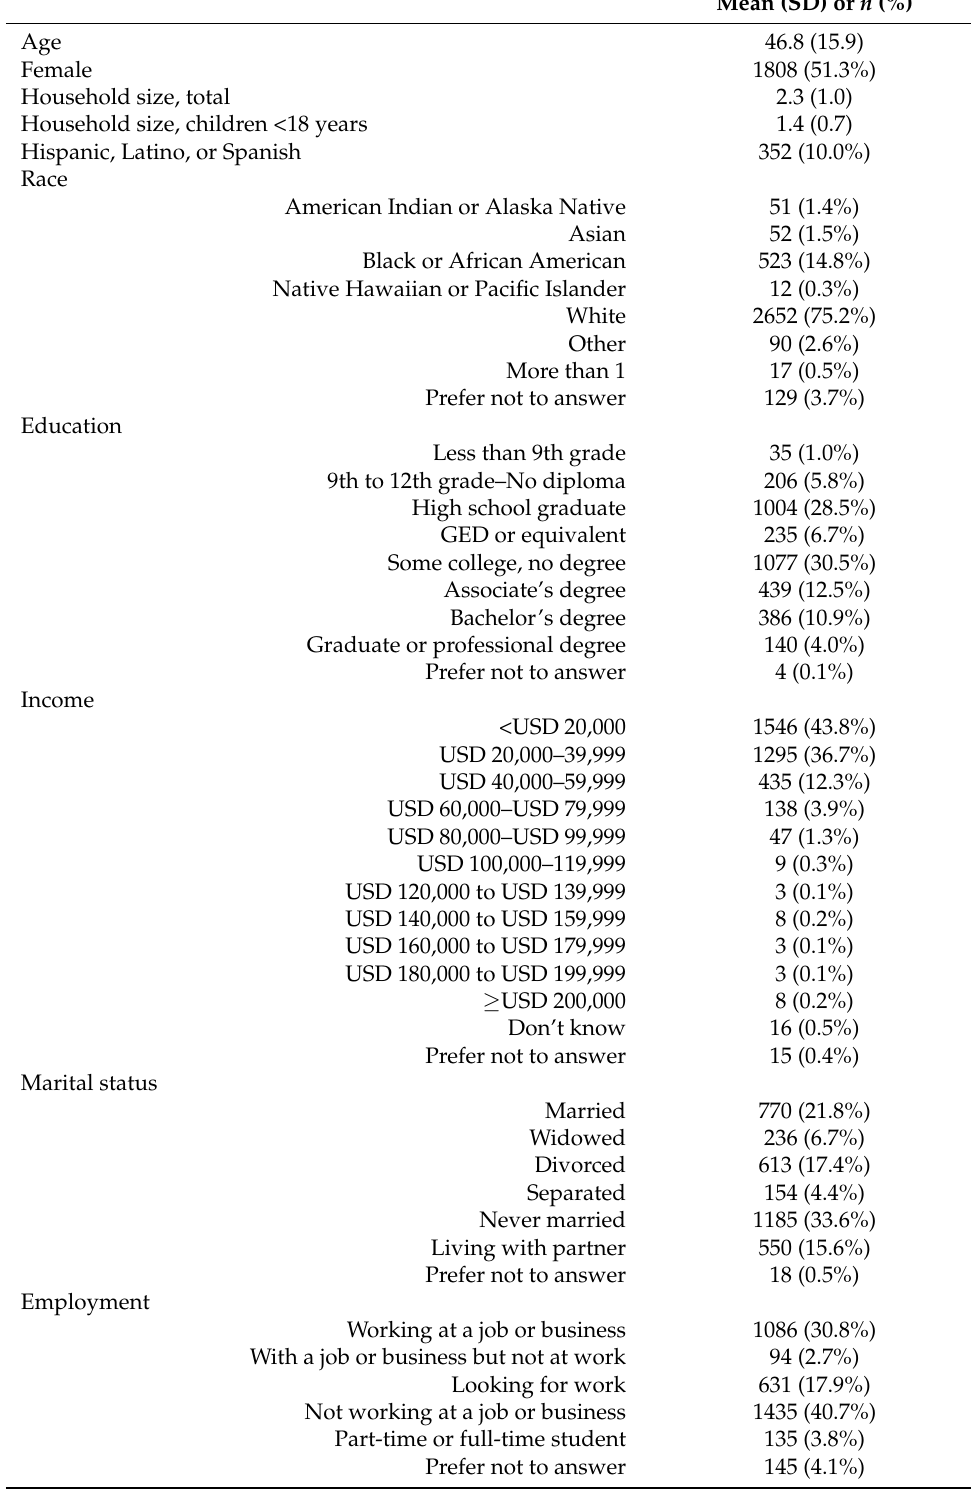
Table 1. Sociodemographic characteristics and diet behaviors a